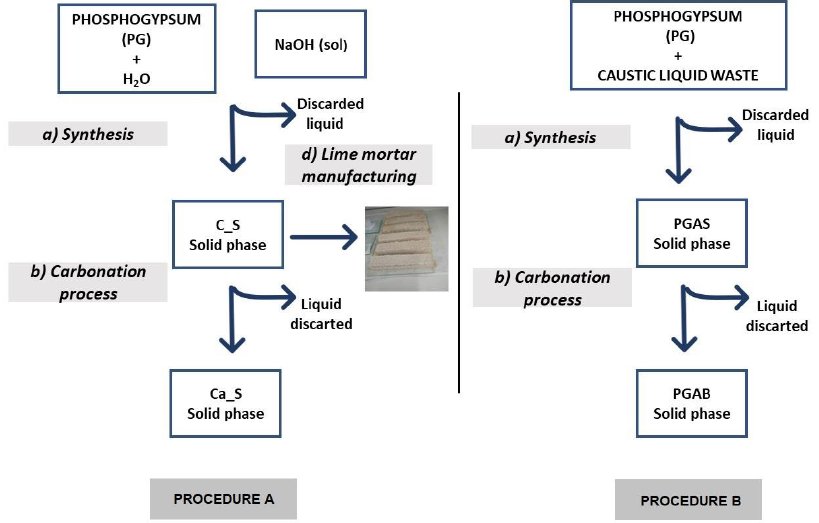
Figure 1. Schemes of both chemical processes.